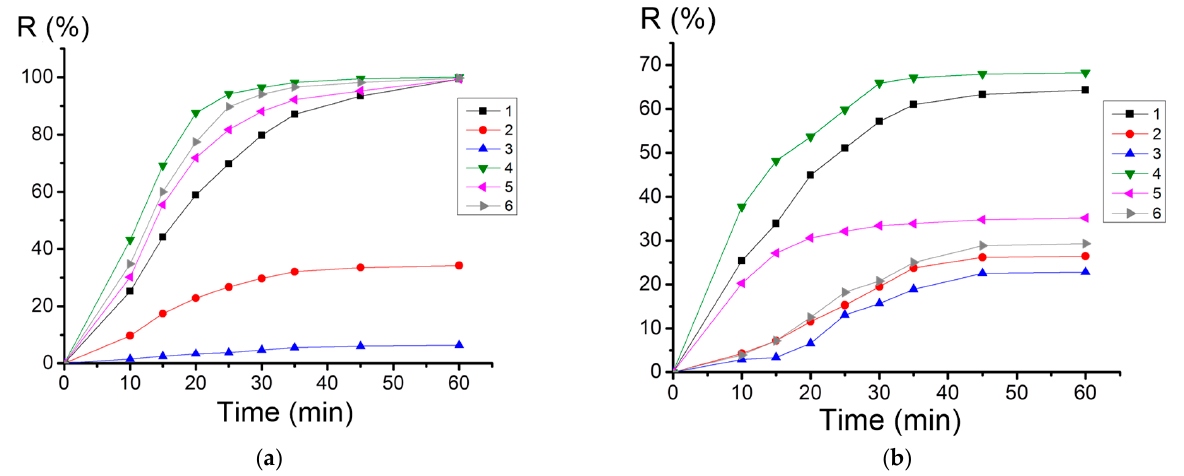
Figure 15. Dependences of the reduction in the bacteria content in the supernatant liquid on the incubation time with nanostructures containing silver ( a ) and without silver ( b ) for samples 1–6. Silver-free samples were of the same morphology, synthesized under the same conditions from Al nanopowder.